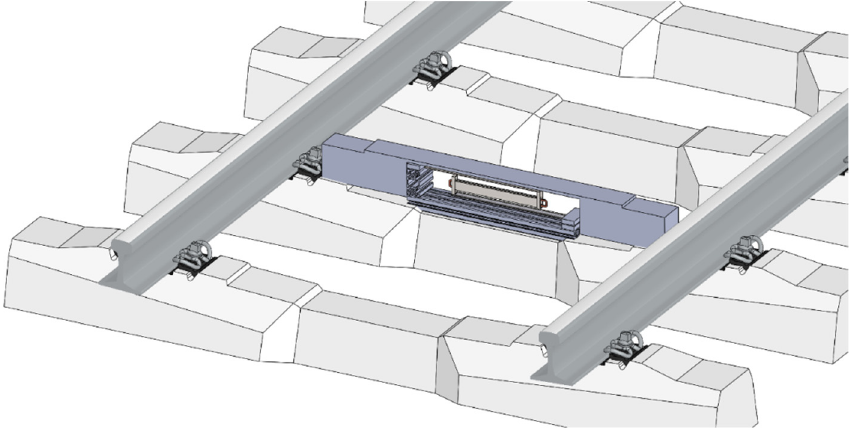
Figure 3. Proposed integration of KEH design for railway applications.